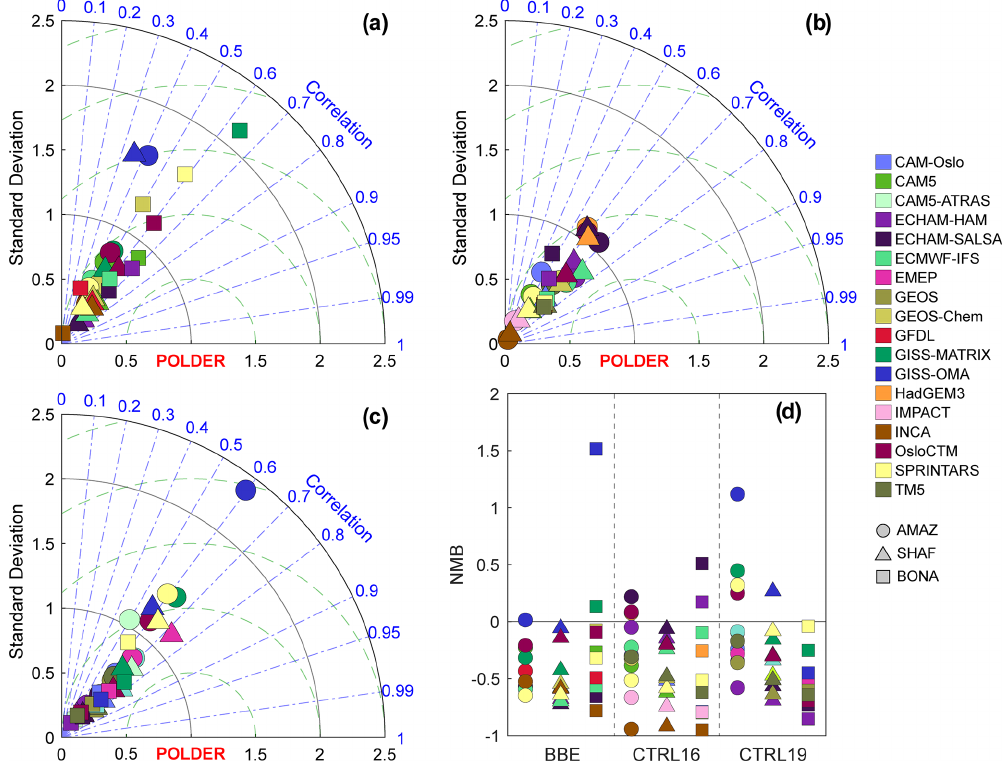
Figure 4. Validation of AeroCom models against POLDER-GRASP observations for AOD during fire seasons. The validations of models from the three AeroCom experiments are shown as Taylor diagrams for BBE (a) , CTRL16 (b) , and CTRL19 (c) . The NMB for all the models is shown in panel (d) . The colors and shapes of dots indicate different models and fire regions. All the model data are collocated with POLDER-GRASP data. The evaluation is for 2008 in BBE; for 2006, 2008, and 2010 in CTRL16; and for 2010 in CTRL19. The GISS-OMA data for BBE over BONA are not shown in (a) due to the very large normalized